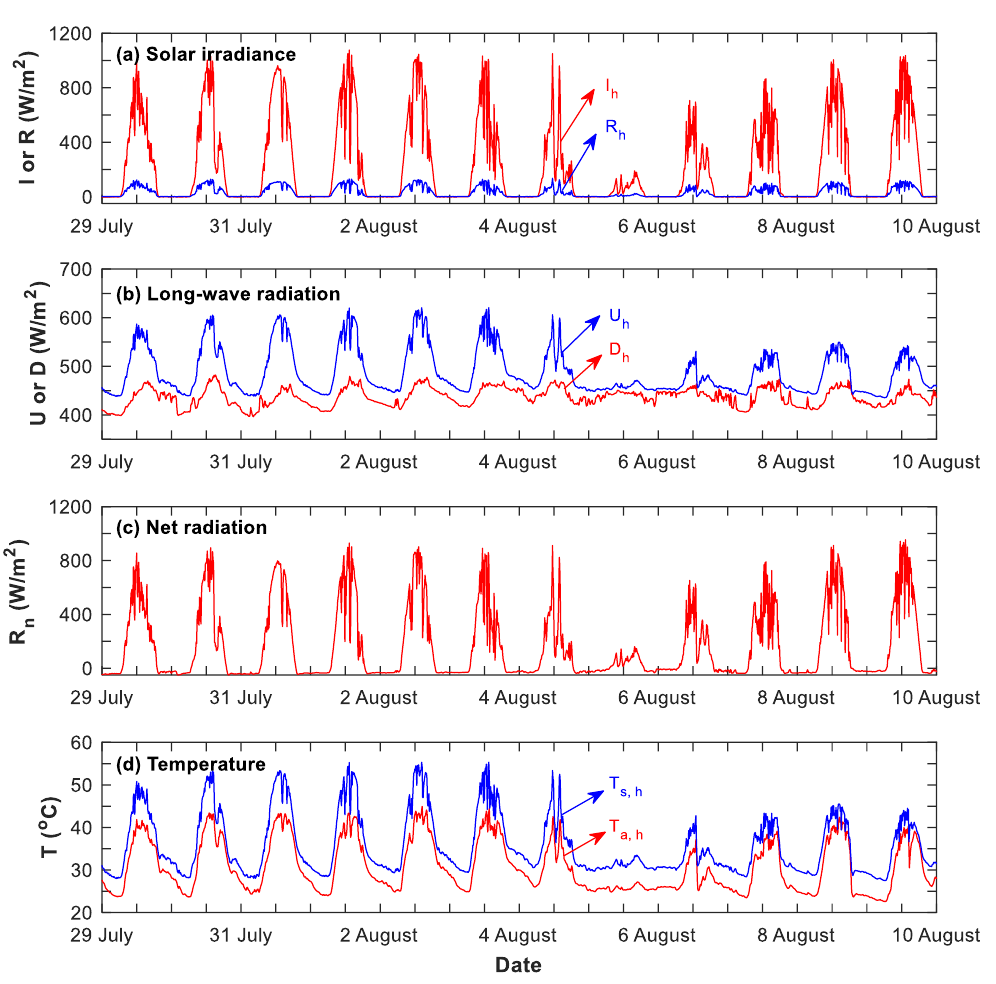
Figure 2. Measured data for ( a ) I and U, ( b ) U and D, ( c ) R n , ( d ) T.